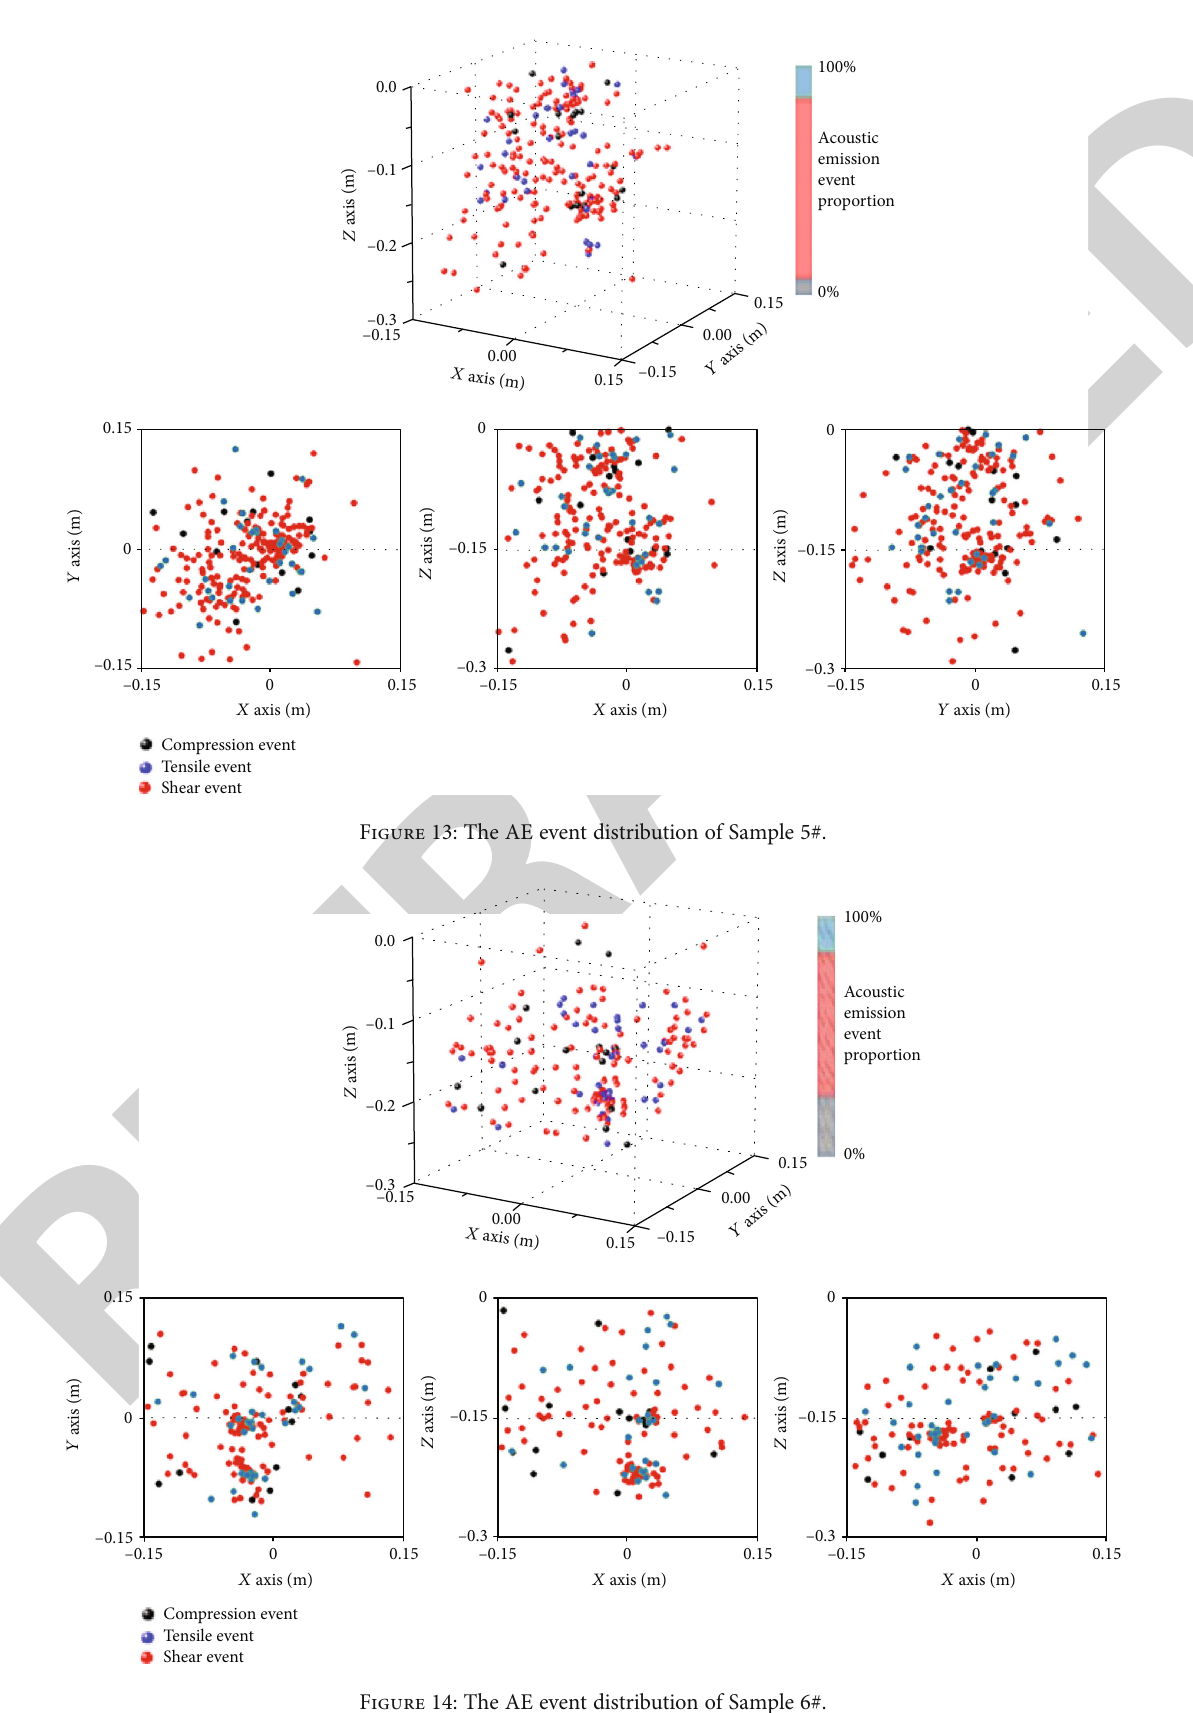
Figure 14: The AE event distribution of Sample